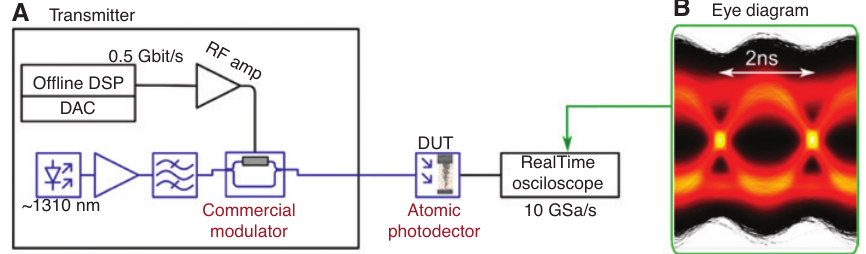
/Pt device (A). (B) The experimental result is 2